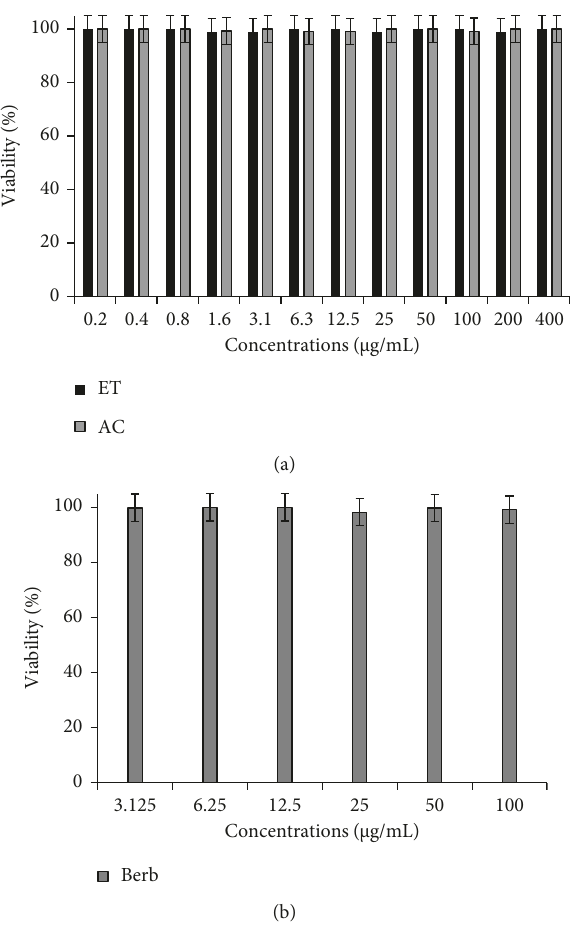
Figure 2: Cytotoxic effect of Berberis vulgaris extracts (a) and berberine (b) against normal human cells PBMCs. ET: ethanol extract, AC: ethyl acetate extract, Berb: